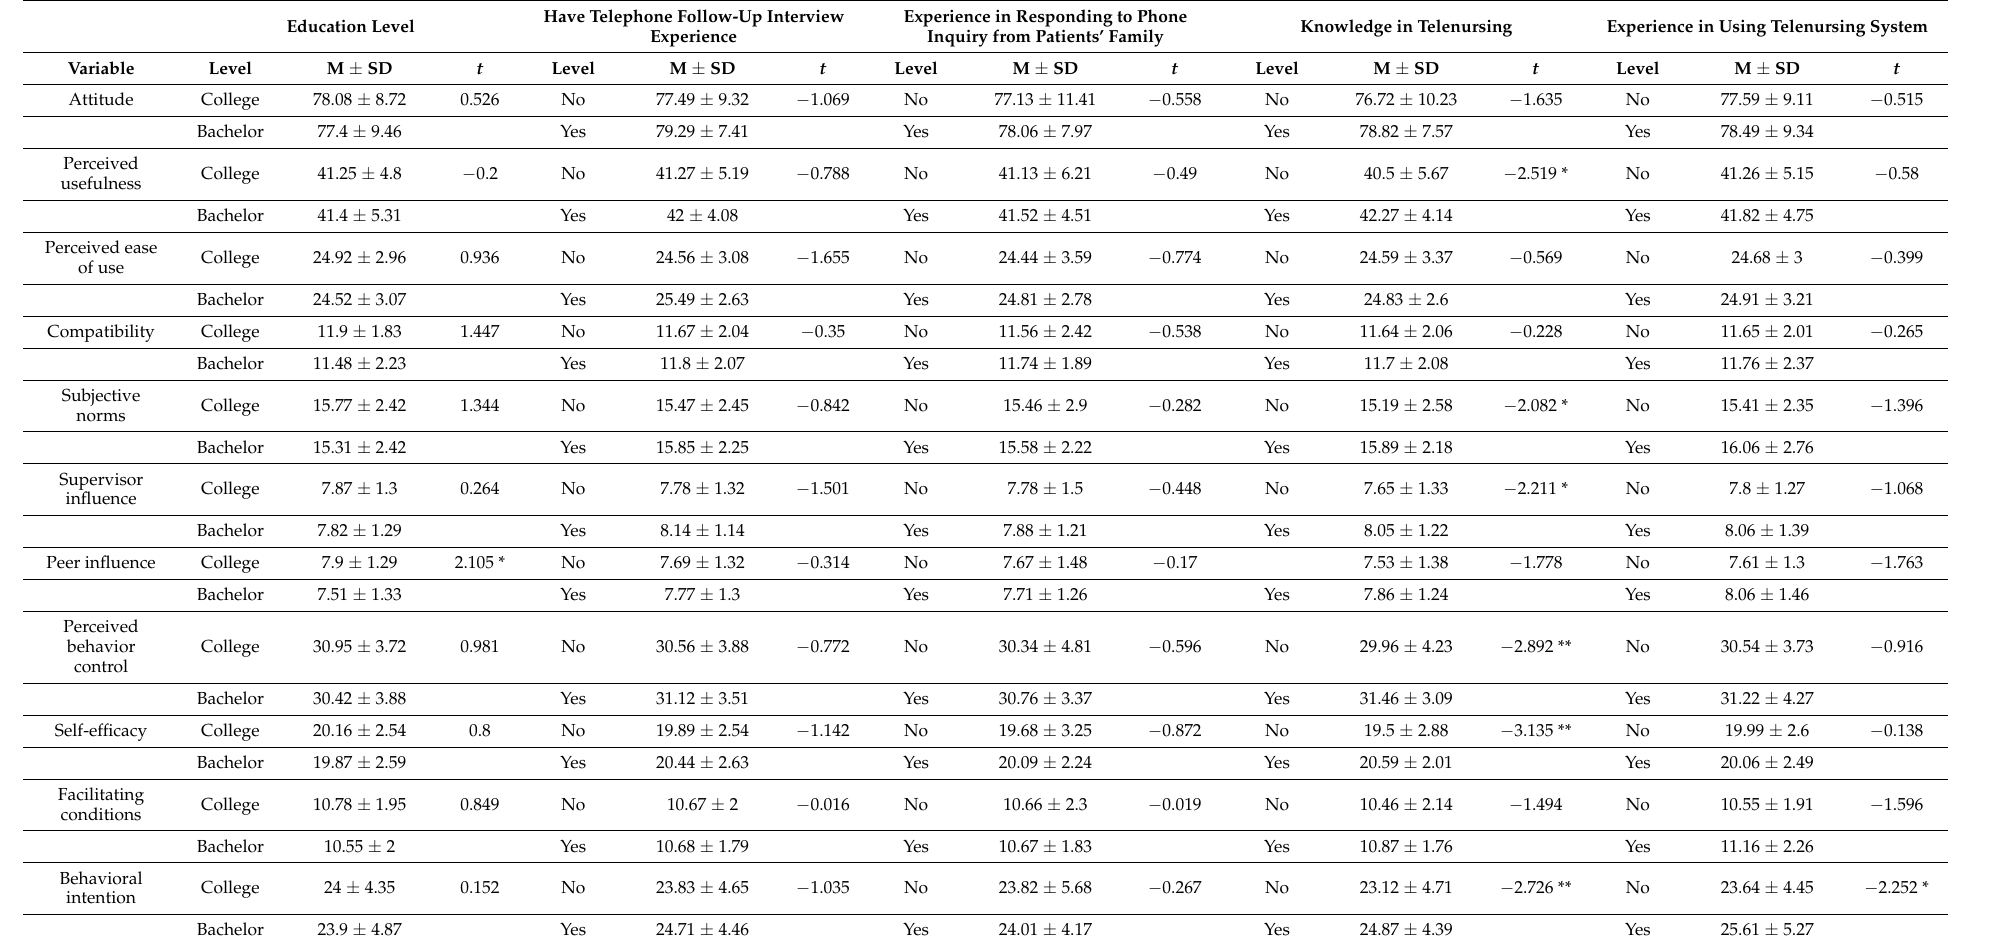
Table 2. Differences between study population characteristics and research